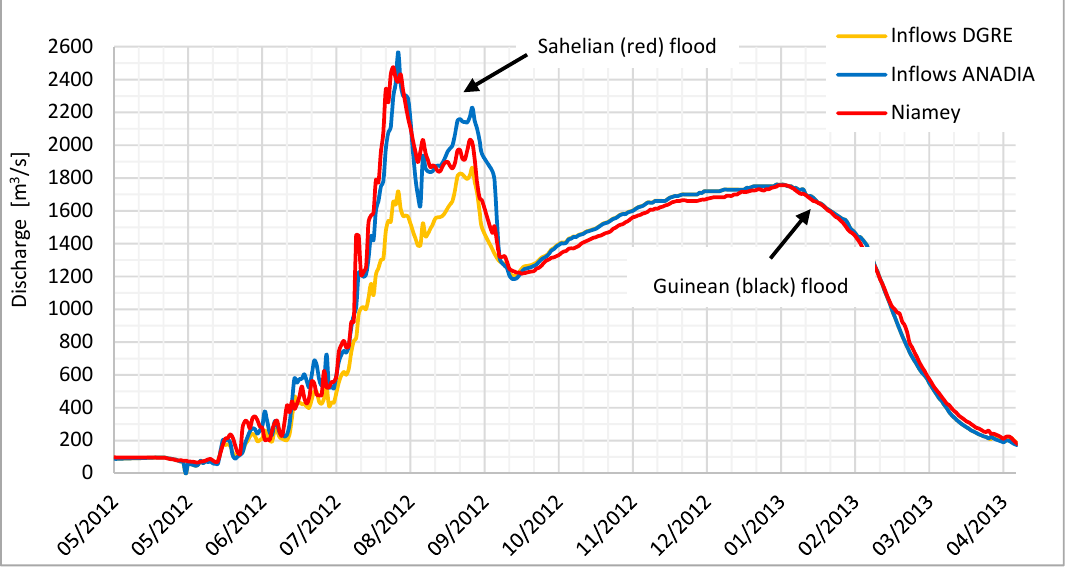
Figure 5. The hydrologic year 2012–2013. Hydrograph at Niamey (red line), cumulative hydrographs of Niger (measured at Kandaji), Dargol (measured at Kakassi), and Sirba (measured at Garbey Kourou) with the ANADIA discharge (blue line) and with the discharge from the DGRE (yellow line).